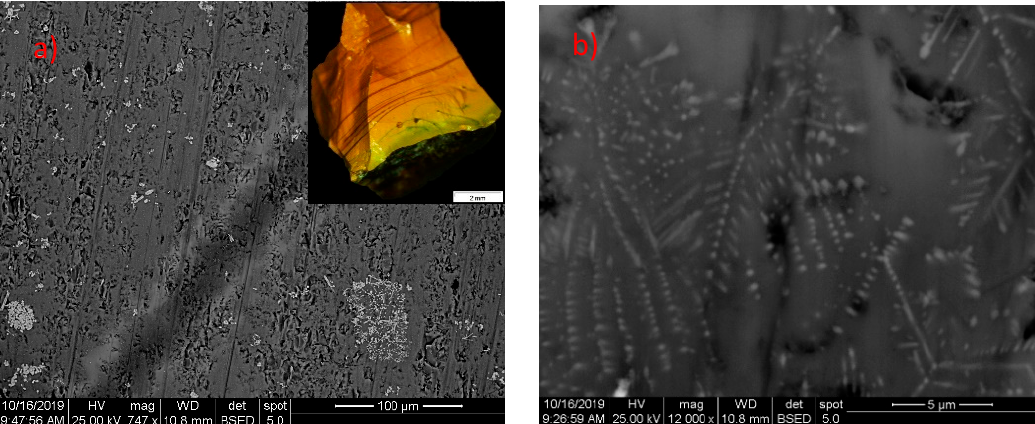
Table 6. Cu-based phases.